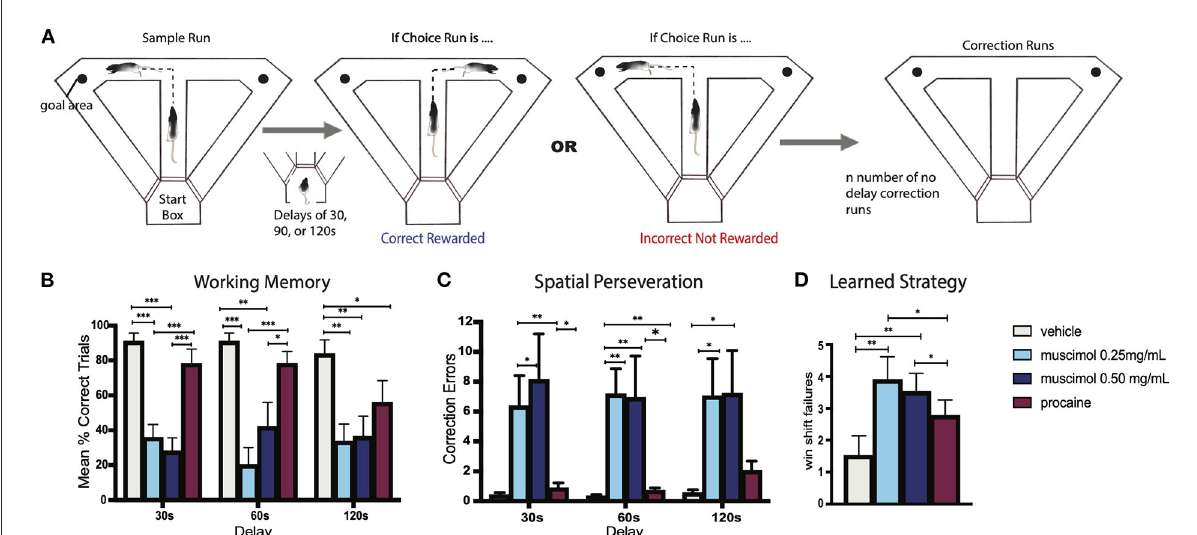
FIGURE5 (A) Experimental design of a modified delayed non-match to sample (DNMS) T-maze task used to examine spatial working memory and behavioral flexibility in the rat. Rats began each trial with a free choice on the sample run, whereby they could choose either arm for